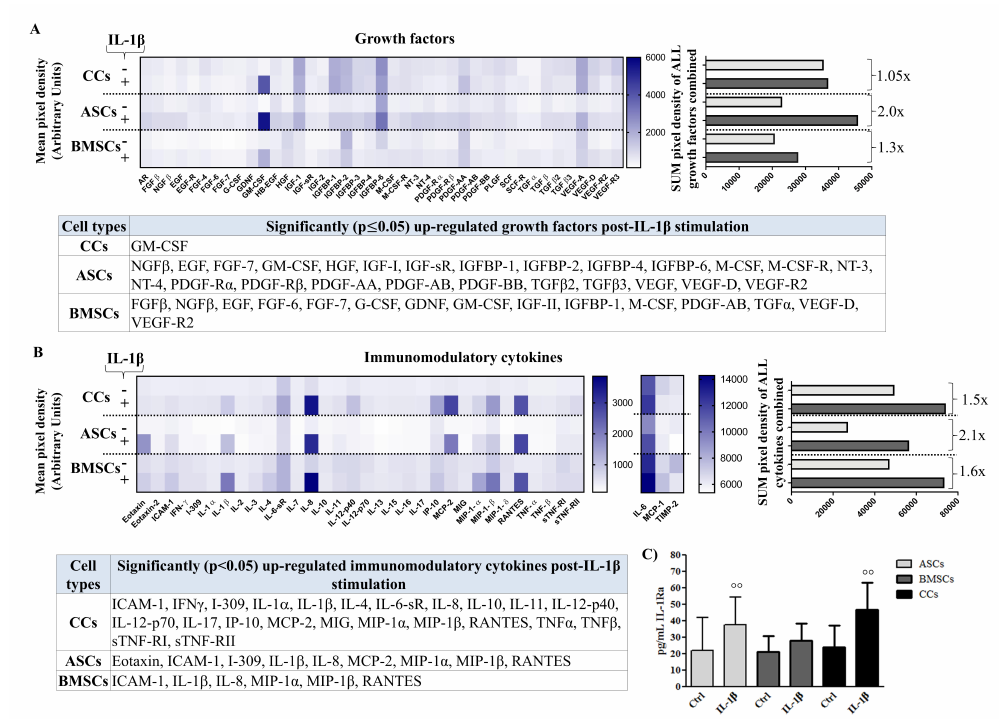
Figure 5. Secretome multiplex analysis. Secretion of growth factors of ( A ) inflammation-related cytokines ( B ) and IL-1Ra ( C ) in conditioned media obtained from adipose (ASCs)-, bone marrow (BMSCs)-derived MSCs, and cartilage cells (CCs) at basal ( − ) and post-stimulation with IL-1 β (+). Growth factors and cytokines are presented as: overall heat maps of the mean pixel intensity, and arithmetic sum of the pixel intensity calculating the fold increase in the overall secretion from basal to post-stimulation; a table showing significantly upregulated molecules with stimulation ( n = 4). For IL-1Ra, ◦◦ p < 0.01 vs. control, data are expressed as mean ± SD ( n = 8). 3.7. CCs Stimulated with IL-1 β Reduce the Proliferation of Activated PBLs in an